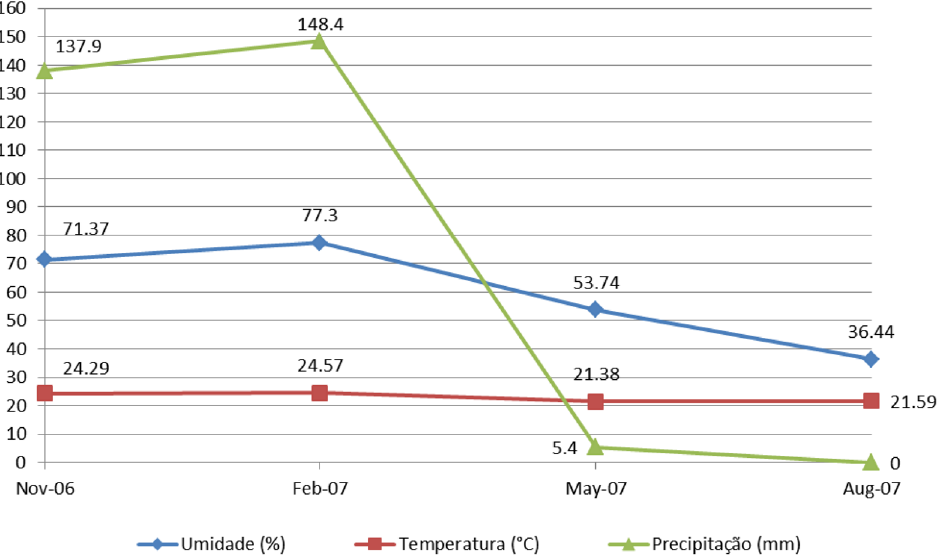
Figure 10. Accumulative month precipitation rate of each collection; average of temperature and humidity in each collection held at Centennial Park Ecological Jatoba. (Standard Deviation of temperature is 1.71, 0.76, 2.03 and 1.67, respectively, as it is not showed on graph, Standard deviation of humidity as showed on